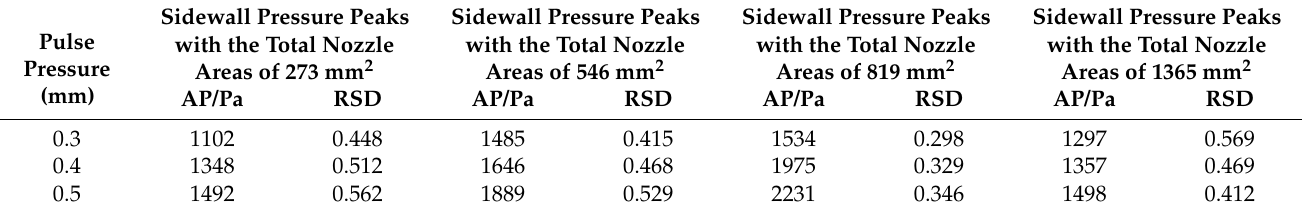
Table 4. The peak pressure distribution law at the nozzles with different pulse pressures.